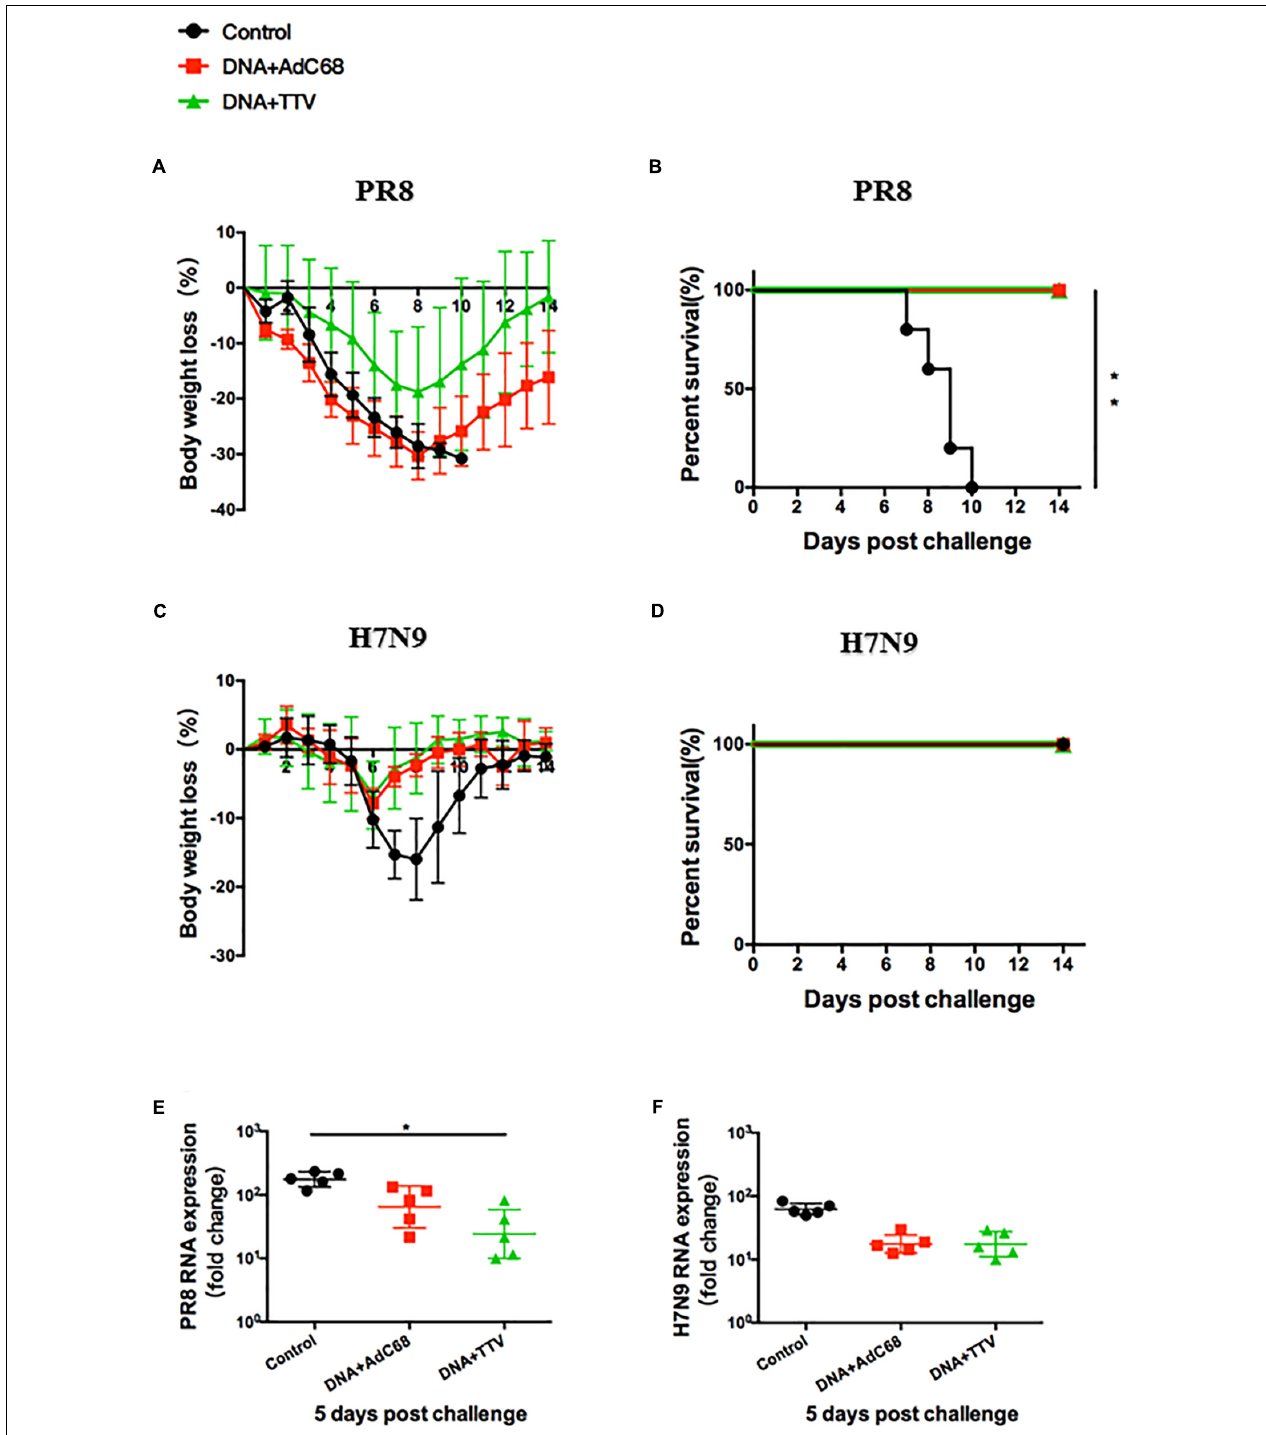
FIGURE 3 | DNA prime-viral vectored vaccine boost strategies conferred protection against PR8/(H1N1) and H7N9 viruses in vaccinated mice. Mice were immunized following schedule outlined in Figure 2A , and 4 weeks later challenged with either 500 50% tissue culture-infective dose (TCID50) of A/PR8(H1N1) or 100 TCID50 A/Shanghai/4664T/2013(H7N9) influenza virus. After infection, mice ( n = 5 in each group) were monitored daily for body weight (A,C) or survival (B,D) . Five mice in each group were sacrificed on day 5 post infection to isolate lung tissues for RNA extraction, followed by RT-PCR quantification of viral RNA to determine the relative viral loads (E,F) . The error bars represent the SDs. Two-way ANOVA test, Mantel–Cox log rank test and t -test were used to determine difference in weight loss, lethality, and viral load, respectively. ∗∗ p < 0.01; ∗ p < 0.05.